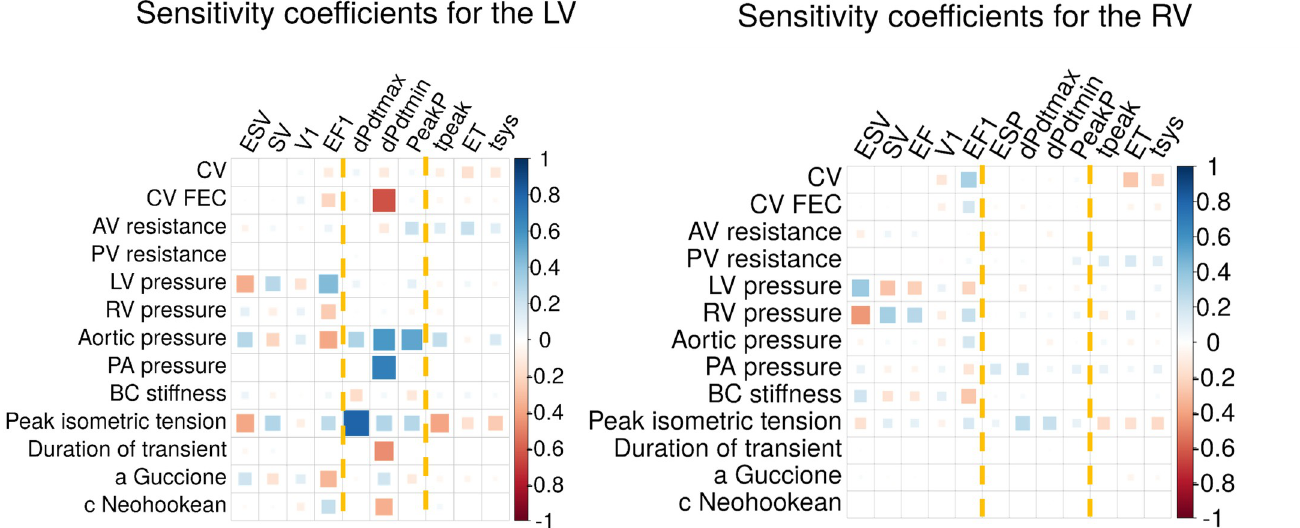
Fig 10. Local sensitivity coefficients for different parameters modified by ± 10% with respect to the baseline value. Each tile indicates percentage of modification of the output per percentage modified of the input. Yellow dotted lines indicate each group of phenotypes: volume-based, pressure-based and time/